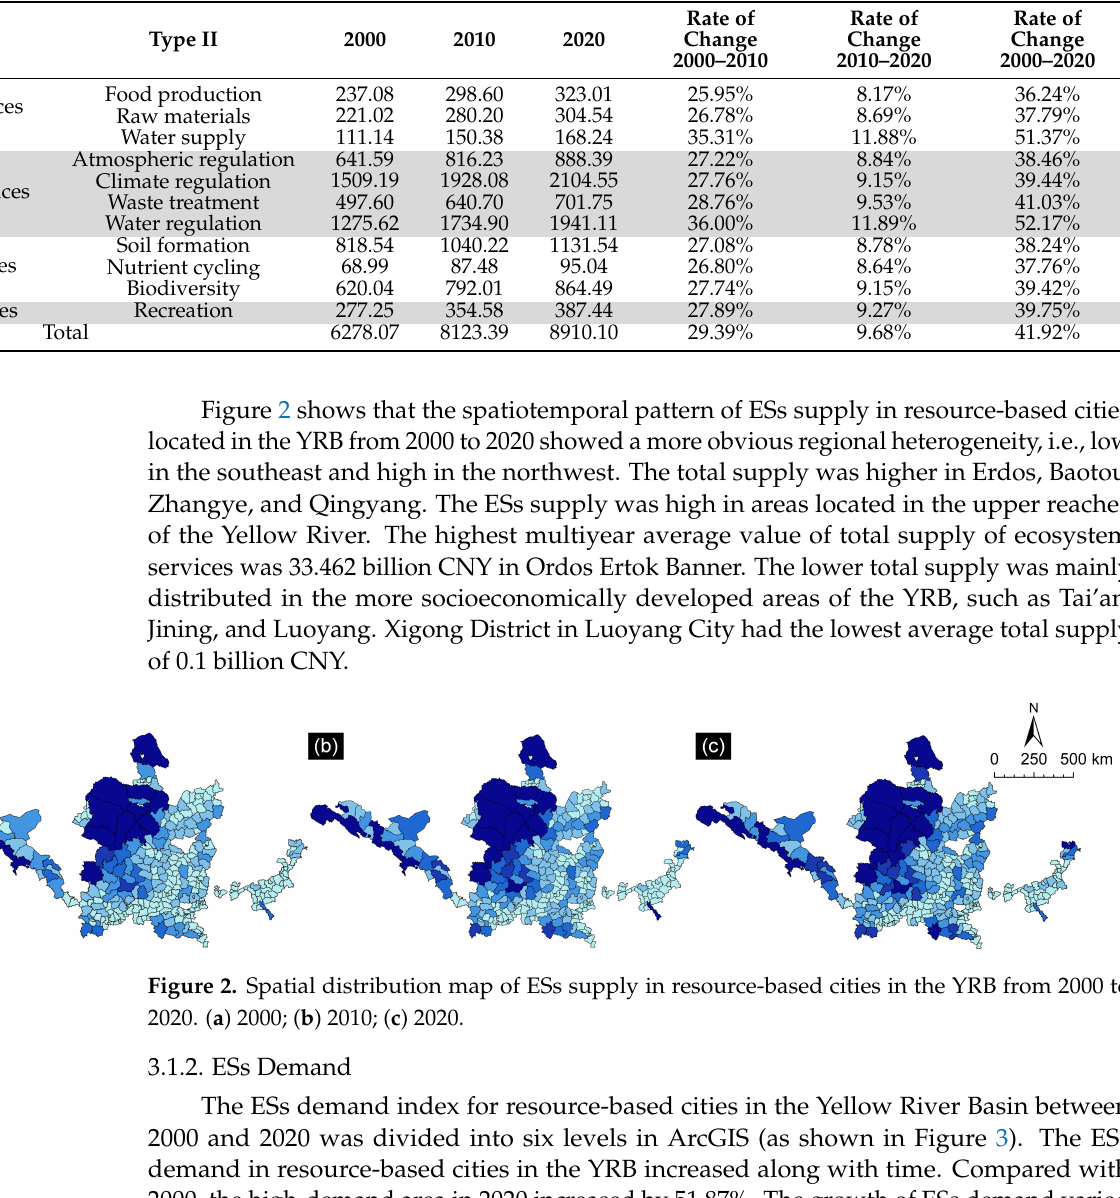
Table 3. ESs supply in resource-based cities in the YRB from 2000 to 2020 (billion CNY).